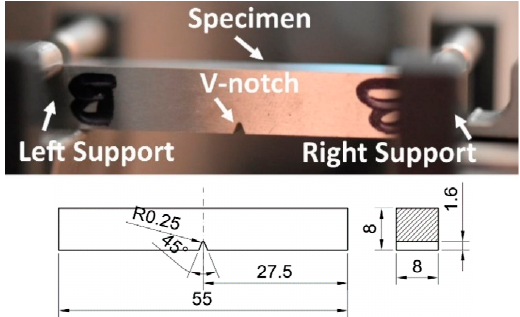
Figure 2. V-notched Charpy specimen in grips and its engineering drawing.